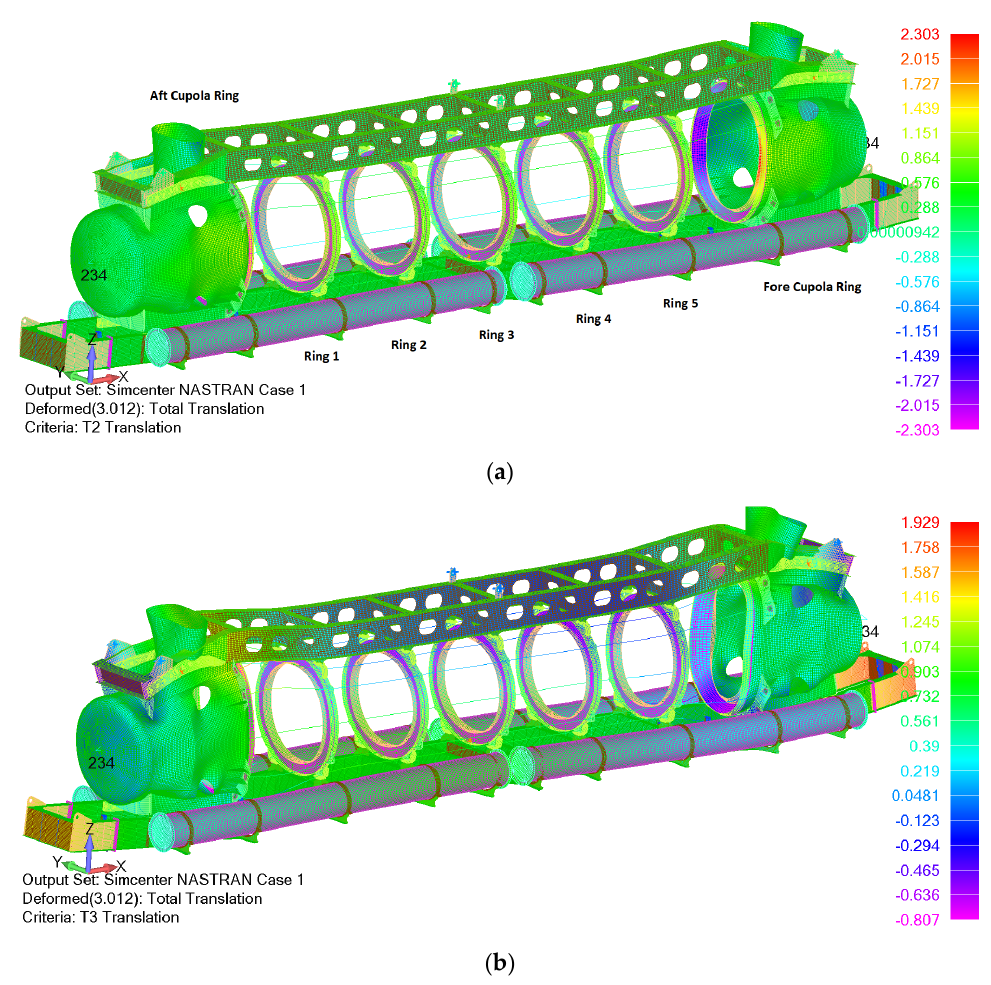
Figure 8. Deformation (in mm): ( a ) y direction (T2), ( b ) z direction (T3).